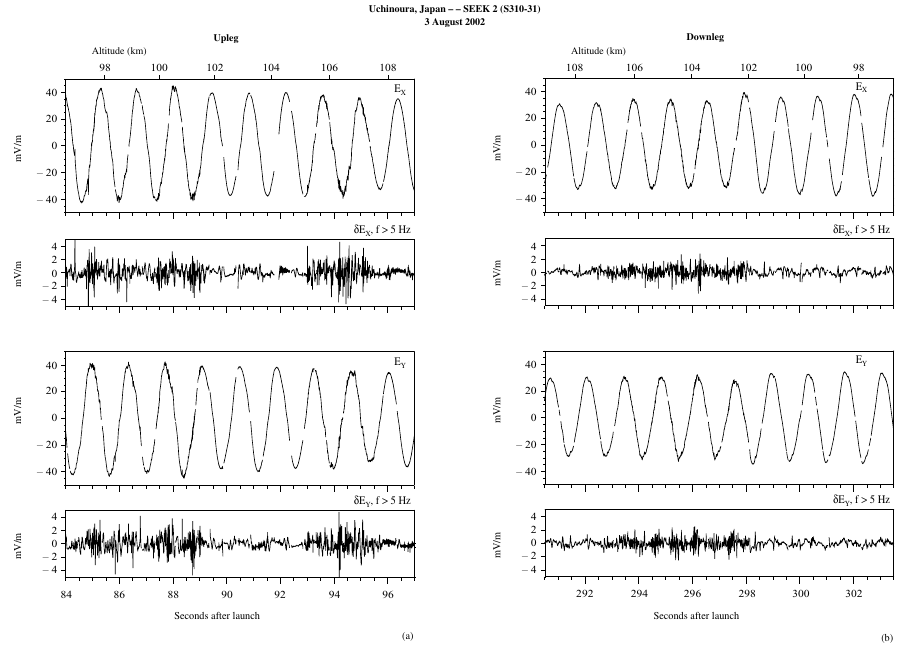
Fig. 5. (a) An expanded view of the raw electric field data gathered between 97 and 109km on the upleg together with the filtered (wave) data for frequencies greater than 5Hz. (b) Same as Fig. 5a but for the